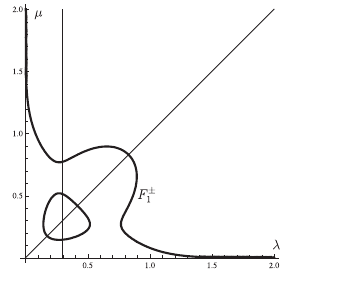
Figure 6. The branch F ± 1 consists of two components.